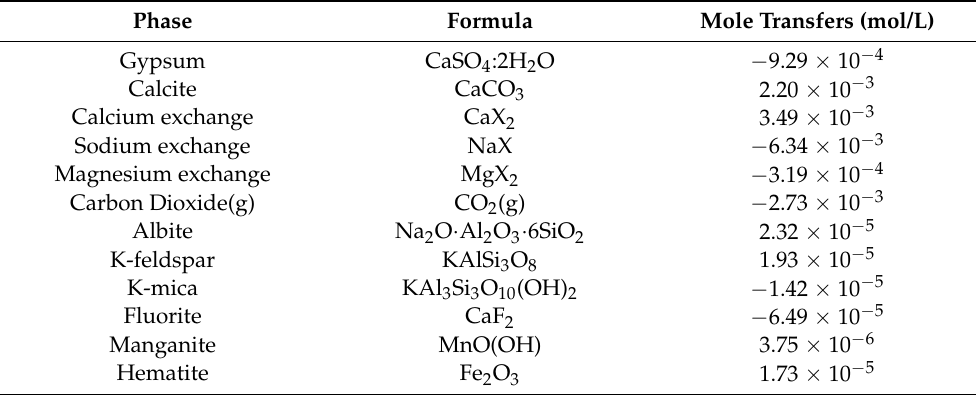
Table 5. Results of the inverse simulation along the reaction